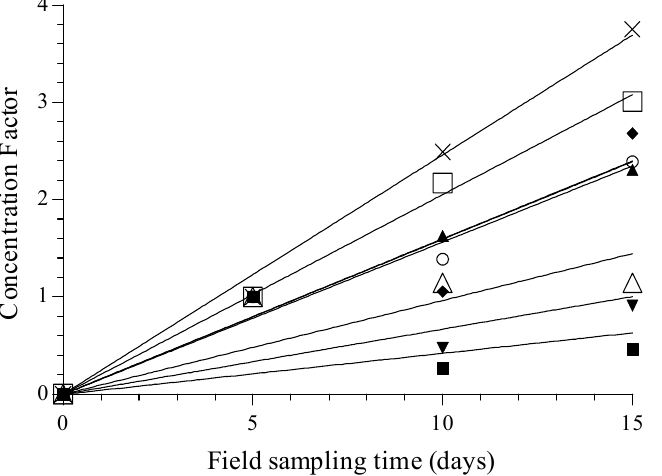
Figure 5. Uptake plot for PAHs. Concentration values estimated for target pollutant compounds in a principal tributary of La Fe reservoir. NAPH ( ✕ ), ACEN ( ■ ), ACE ( Δ ), FL ( ▼ ), PHE ( ♦ ), ANT ( ○ ), FLU ( □ ) and PYR ( ▲ ). The concentration factor was calculated as the ratio between the minimum concentration value found for each target compound and all estimated concentrations. C w was calculated by multiplying the initial concentration by the concentration factor.